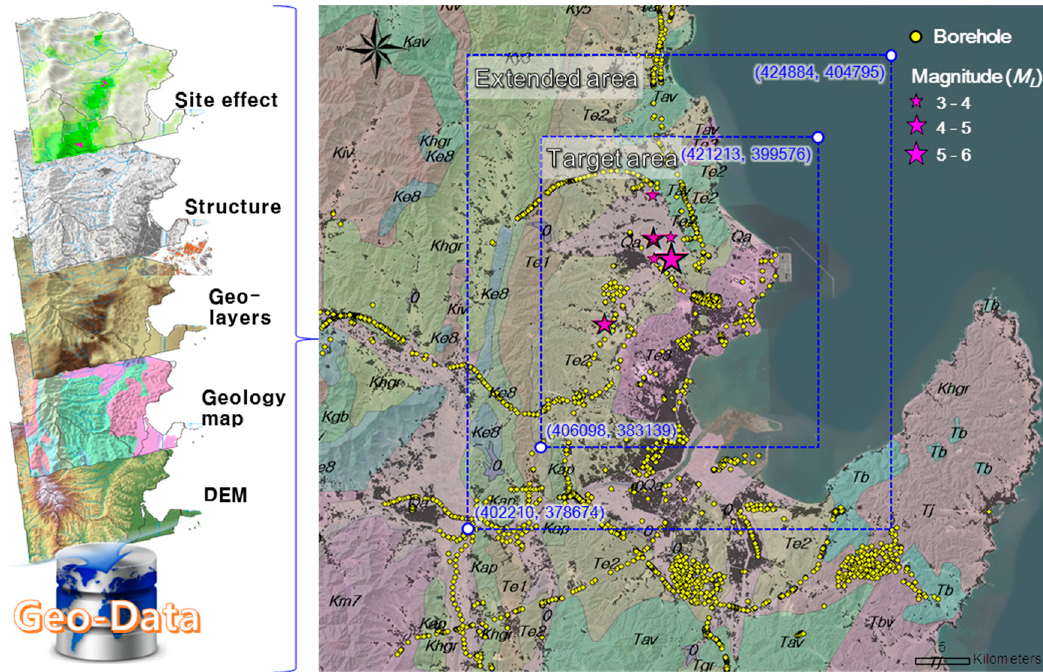
Figure 3. Extended and targeted areas for spatial modeling of geo-data in Pohang. Figure 4. Extended and targeted areas for spatial modeling of geo-data in Pohang.